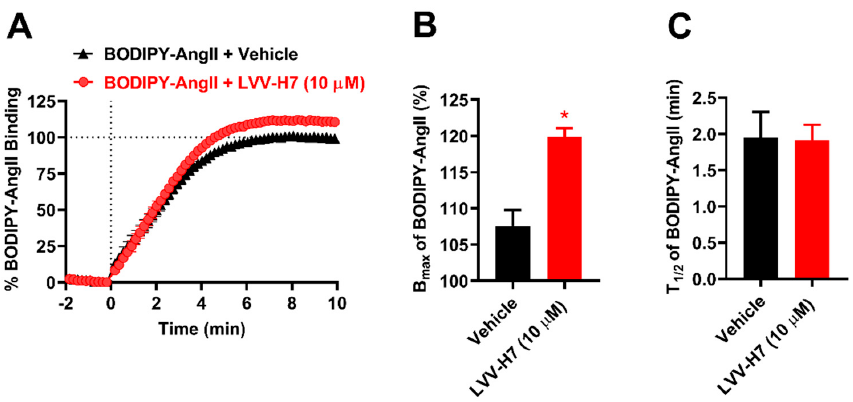
Figure 3. Real-time kinetics of the binding of BODIPY-AngII to AT1R in the presence of LVV-H7 using NanoBRET assay in live HEK293FT cells. ( A ) HEK293FT cells transiently expressing Nluc- AT1R (NanoBRET donor) were first treated with 10 μ M LVV-H7 or vehicle for 30 min. BRET sig- nals were then measured immediately after treatment of cells with 100 nM of BODIPY-AngII.